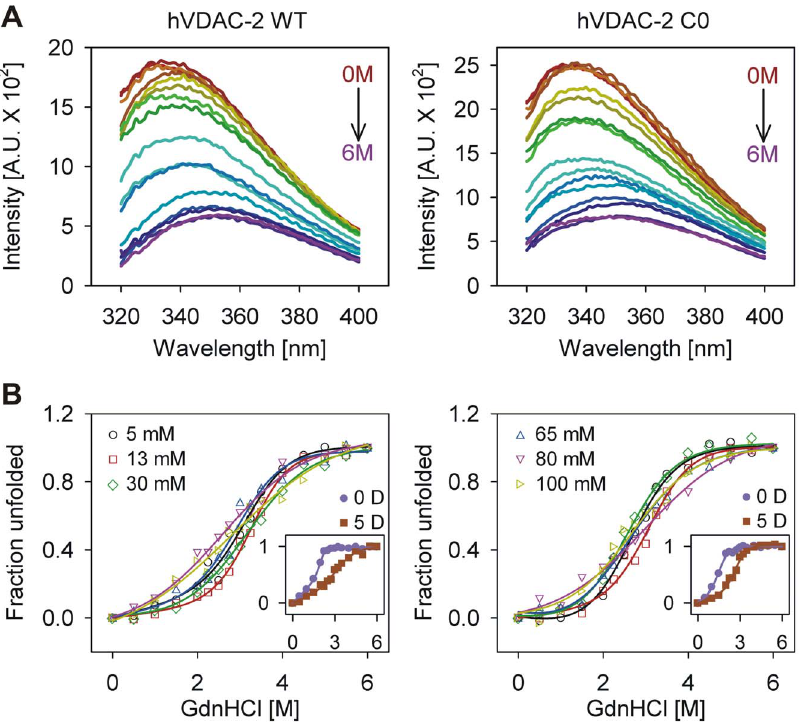
Figure 6. Equilibrium unfolding studies of refolded hVDAC-2 using GdnHCl. (A) Representative Trp fluorescence wavelength scans of refolded hVDAC-2 WT (left) and C0 (right) in 13 mM LDAO in a GdnHCl gradient, recorded after 1 h incubation at 25 u C. Note the decrease in intensity as well as the red shifted l em-max in GdnHCl, indicating near-complete protein unfolding. (B) Refolded hVDAC-2 WT (left) and C0 (right) in different LDAO concentrations were subjected to an increasing GdnHCl gradient at 25 u C. The plots represent unfolded fractions derived from the change in Trp fluorescence intensity at 340 nm, as the protein unfolds. Solid lines denote fits to a two-state equation, except in the case of 80 mM and 100 mM experiments, wherein a sigmoidal fit was used to illustrate the trend in the dataset. Also shown, as insets, are the unfolding curves obtained for aggregated protein (protein in buffer; 0 D) and hVDAC-2 refolded directly in 5 mM LDAO (5 D; LPR of 1000:1). Note the shift in C m for the former and/ or loss in cooperativity in the latter. The color scheme used in Figure 5for the various samples is also retained here. Legends are distributed in the left and right panel. Data points shown here are the mean of three datasets and error bars are omitted for clarity. proteins 1 h after addition of denaturant, at 25 u C (Table S1 in File S1). In line with the C m values, the data point to greater stability of WT over C0 by , 0.7 – 1.0 kcal/mol. Both proteins display